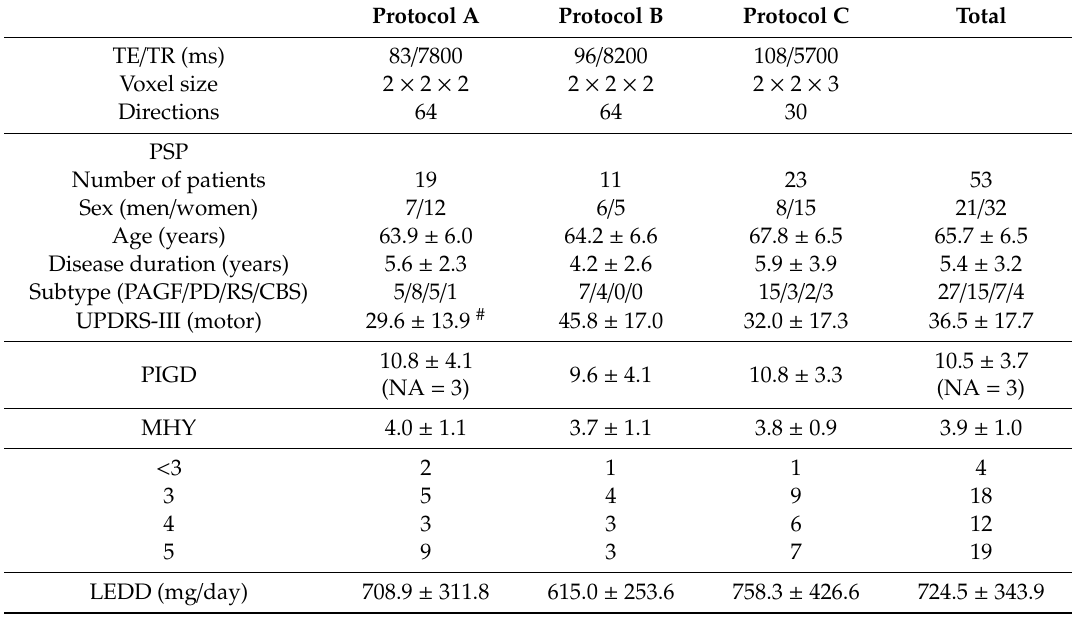
Table 1. General characteristics of the study patients and clinical scores of progressive supranuclear palsy (PSP)